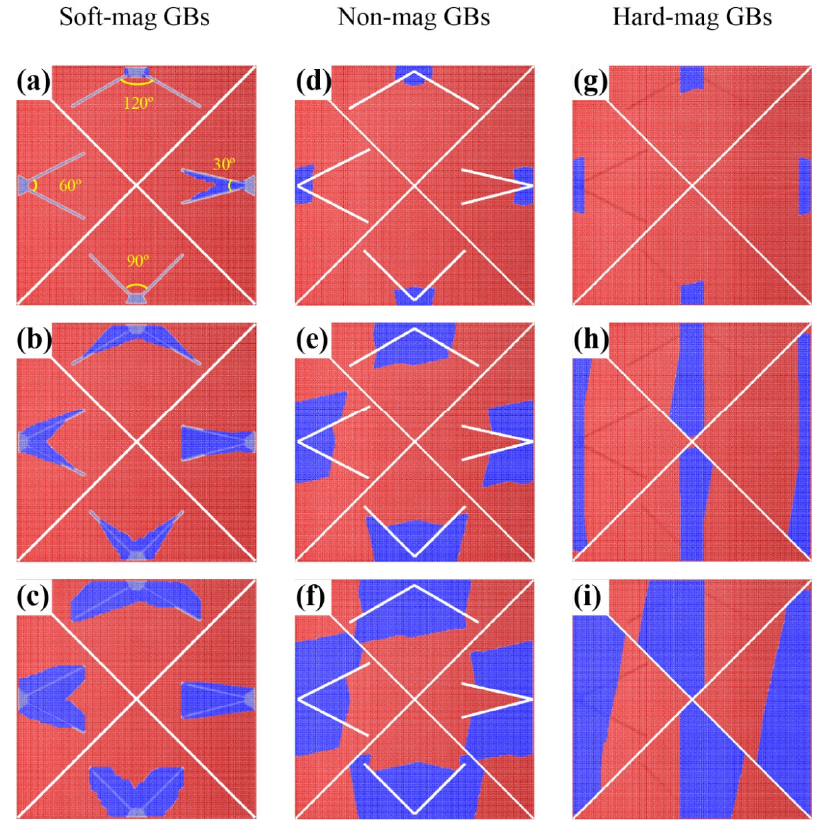
Figure 5. Propagation of reversed domains around 30°, 60°, 90° and 120° GB included angles. ( a – c ) Soft-magnetic GBs; ( d – f ) nonmagnetic GBs; ( g – i ) hard-magnetic GBs. The initial nucleation site was set at the vertex of each angle.